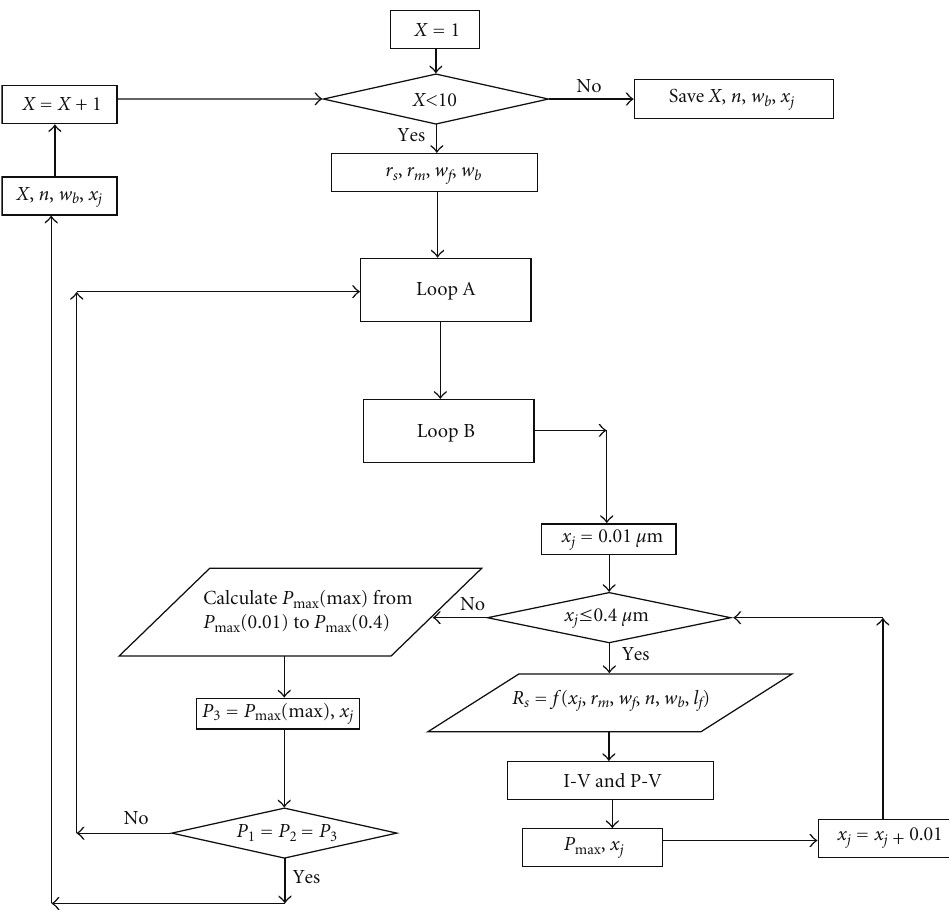
Figure 5: Flow chart for emitter junction depth optimization along with grid optimization.